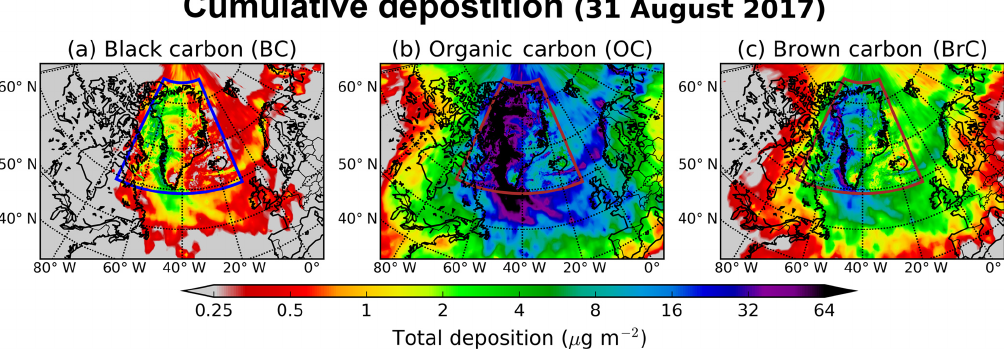
Figure 2. Total (wet and dry) deposition of (a) BC, (b) OC and (c) BrC (in µgm − 2 ) from the Greenland fires until 31 August 2017. The colored rectangle depicts the nested high-resolution